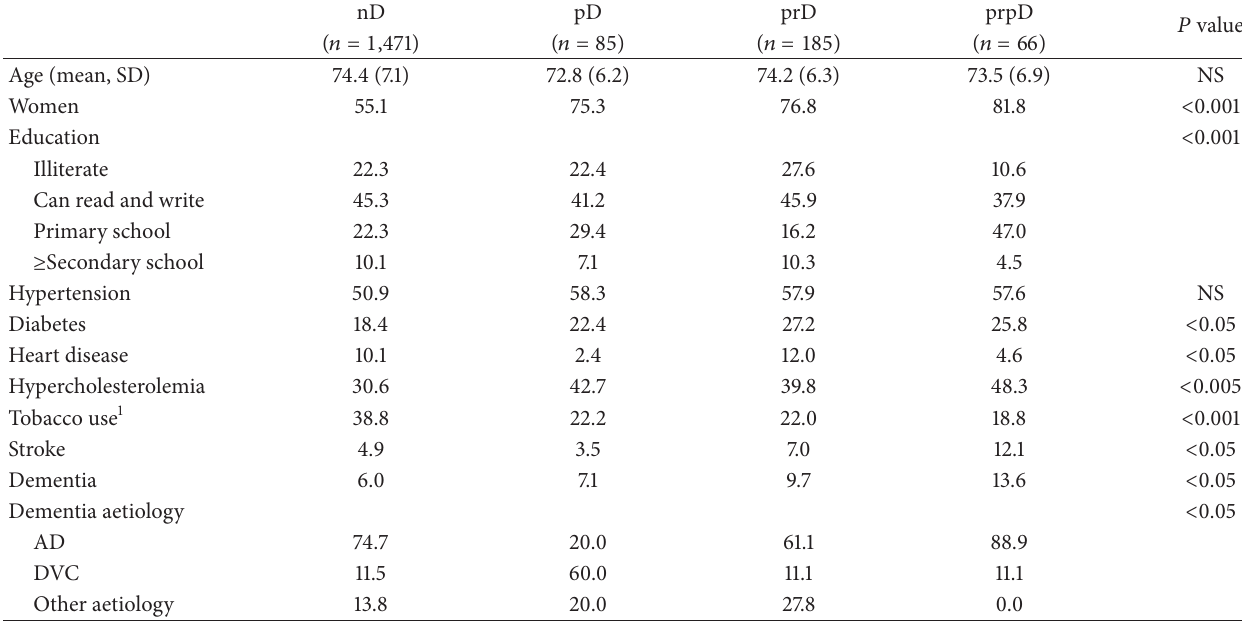
Table 2: Characteristics of subjects in the four study groups.